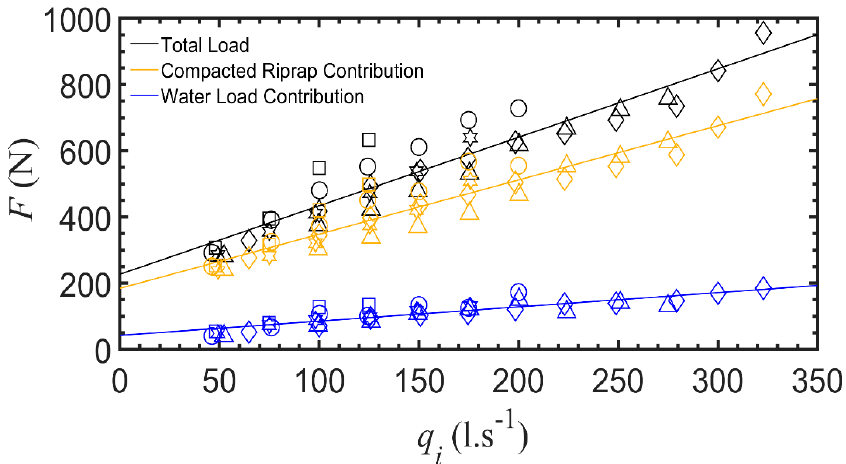
Figure 7. Contribution of the compacted riprap and water loads in the measured total axial load for all tests. The different symbols stand for the five different tests and correspond to the ones displayed in Figure 6 ( a − e ).